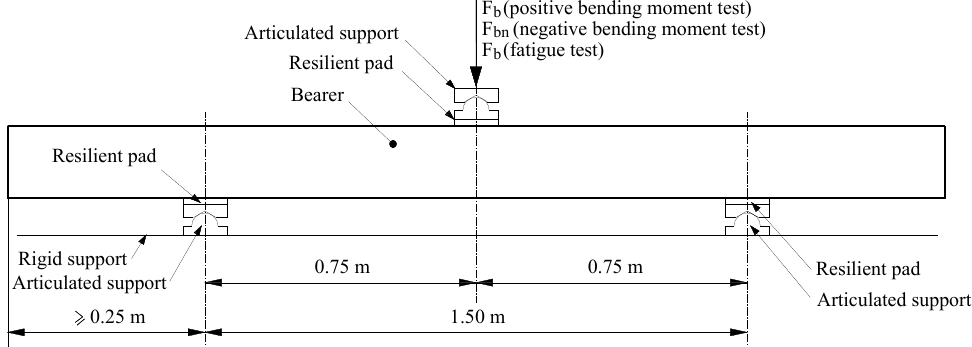
Figure 8. Test arrangement for the positive and negative bending moment tests and fatigue test.